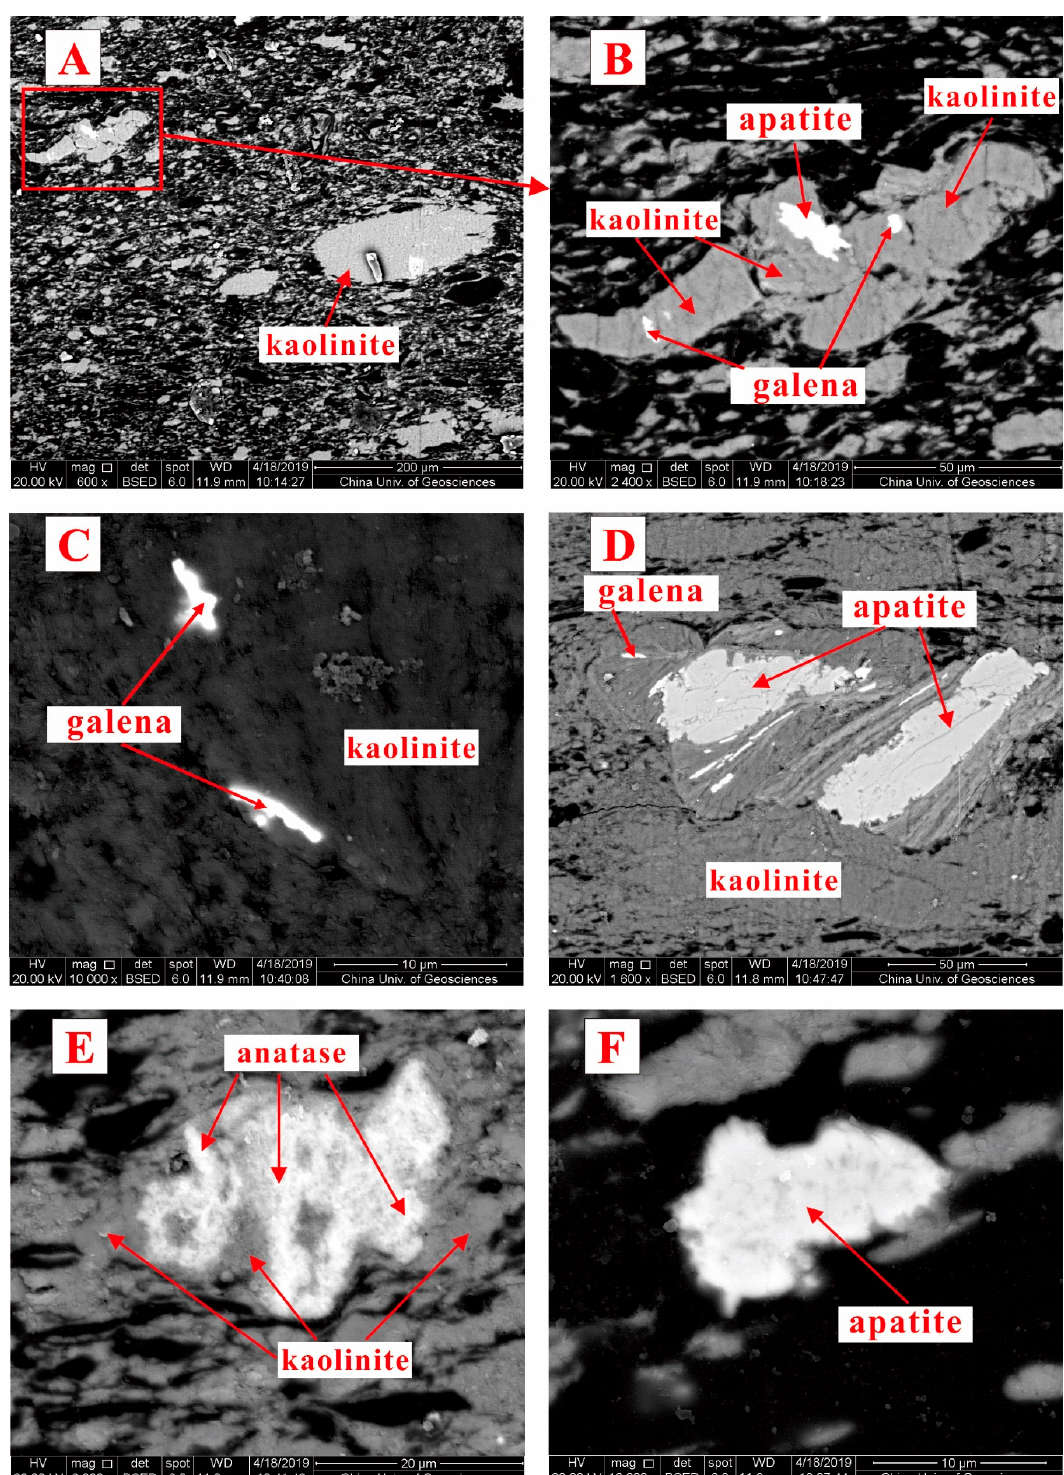
Figure 7. SEM back-scattered images of kaolinite, apatite, galena and anatase in the parting sample of PR-4-4 (P). ( A ) dispersed kaolinite particles; ( B ) vermicular kaolinite; ( C , D ) apatite, galena fillings cavity of kaolinite; ( E ) kaolinite matrix, anatase filling the cavities of kaolinite matrix; ( F ) cell-filling apatite.